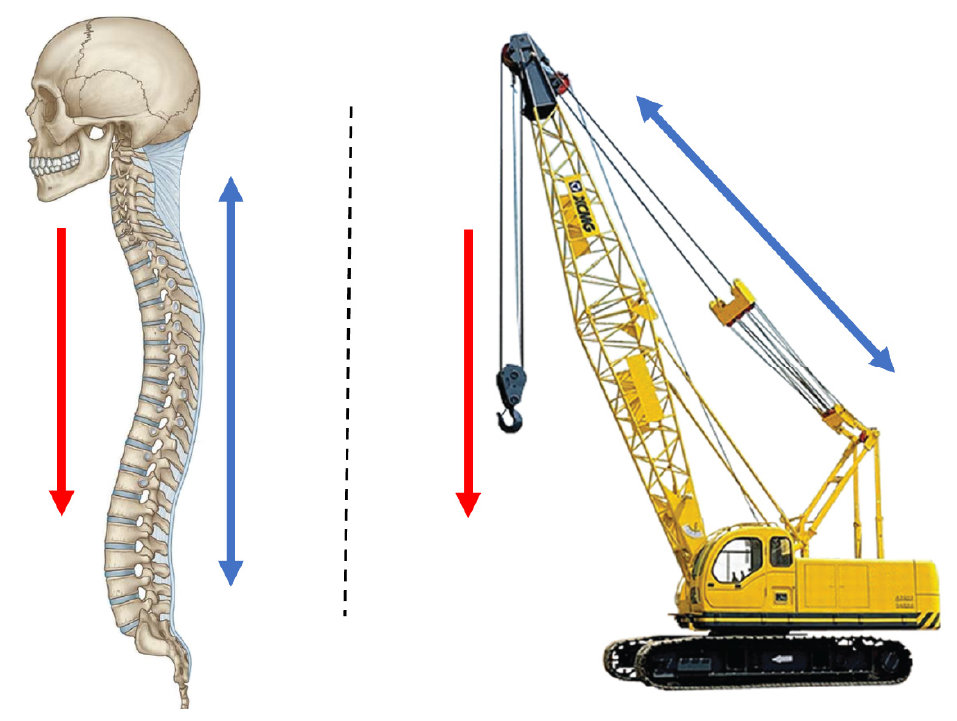
Figure 9. Resemblance of spinal balance equilibrium with a crane. Red arrows represent (body) weight carried by the vertebrae ( left ) and crane arm ( right ). The blue arrows represent the stabilizing counterforce (tension) by the posterior ligamentous complex ( left ) and tension cables ( right ).